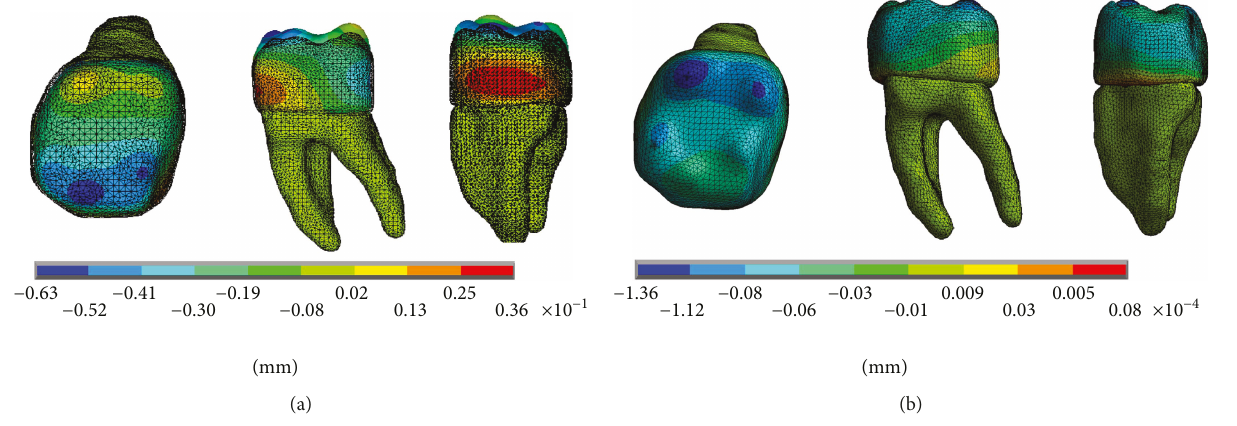
Figure 11: Displacements in the y -axis. (a) Noncontact. (b)